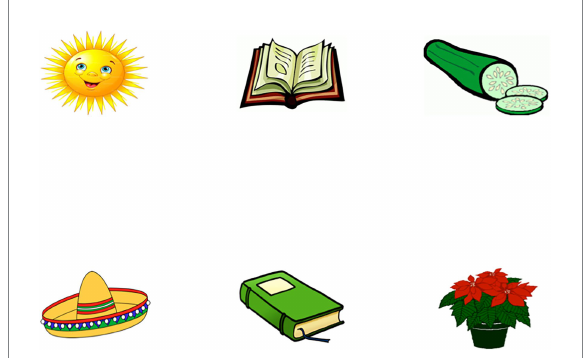
FIGURE 1 Sample trial in the Hard condition. The target image was the open book, top row